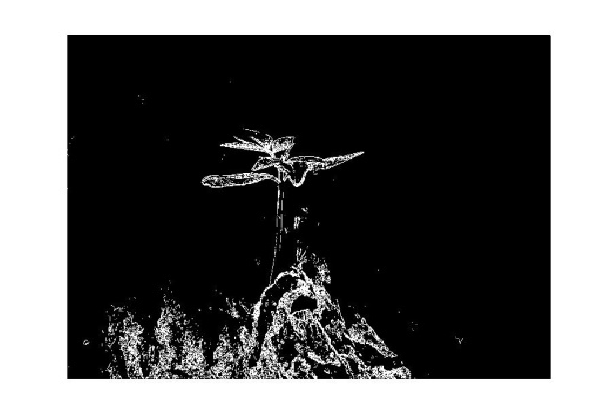
Figure 2.2 Segmented Plant Image